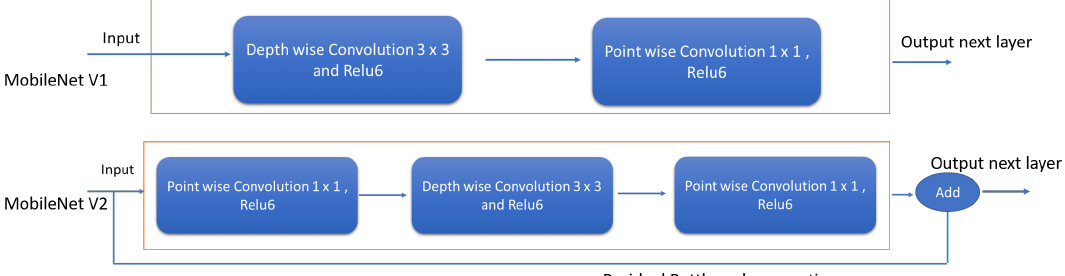
Figure 4. Difference between MobileNet V1 and MobileNet